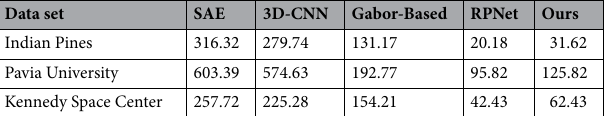
Table 8. The computation time using five methods on three data sets